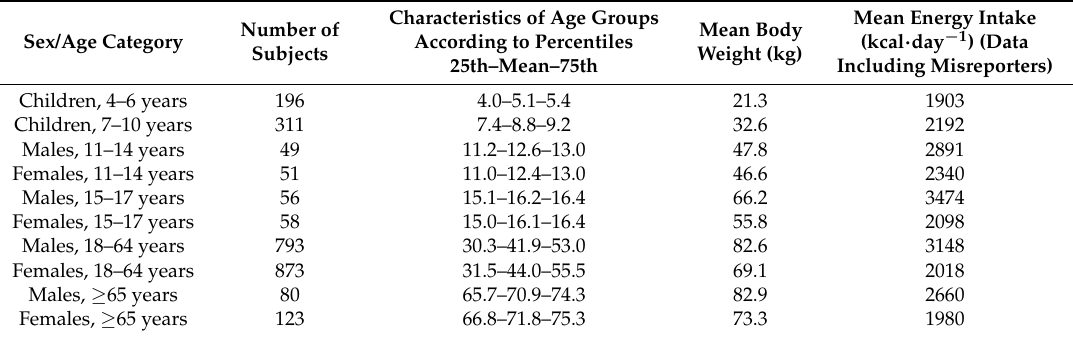
Table 1. Characteristics of studied Czech population